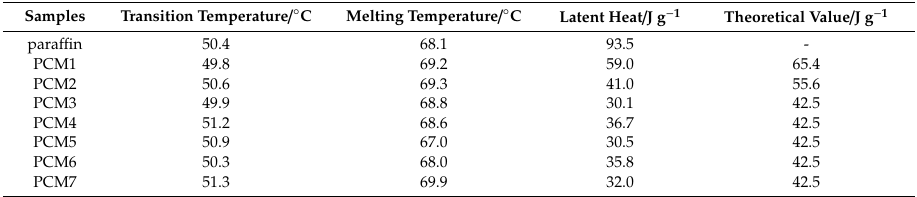
Figure 5. Di ff erential scanning calorimeter (DSC) curves of the samples. Table 4. Thermo-physical properties of the PCMs.